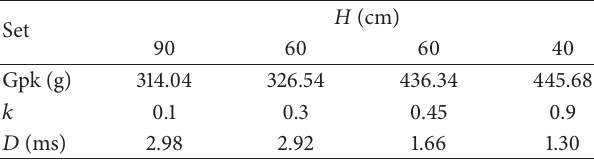
Table 2: Test data sets by free-fall shock